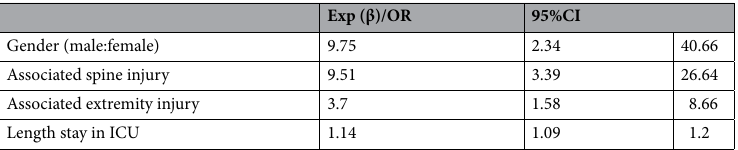
Table 4. Multivariate logistic regression analysis of risk factors of CIVTE. Exp (β) exponentiation of the β coefficient, CI Confidence Interval. The OR for Length stay in ICU refers to precent of VTE increasing per 1 day.